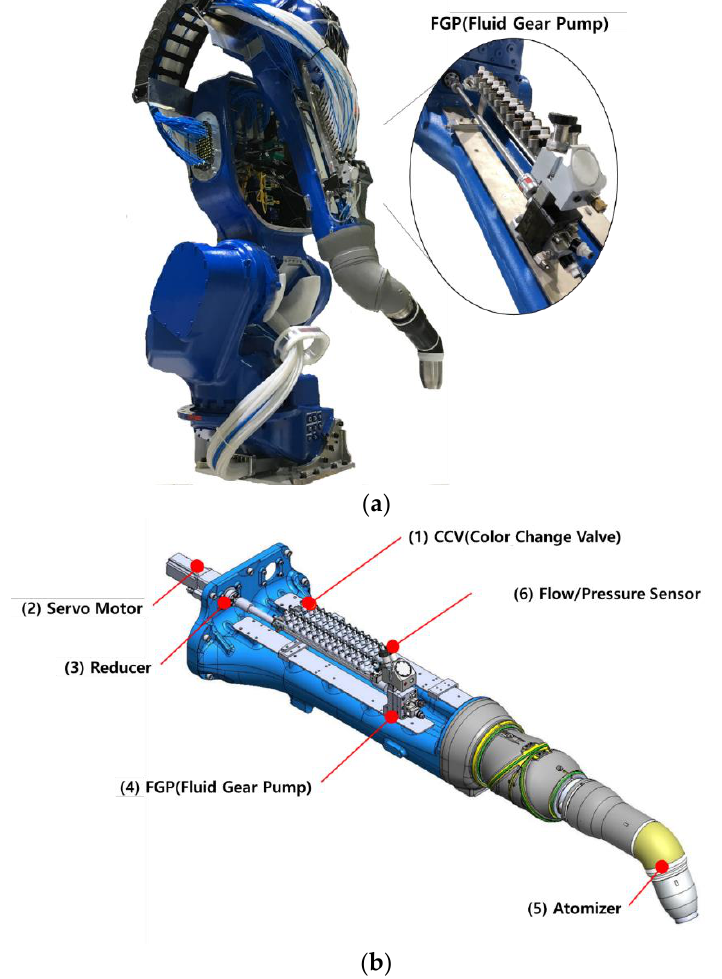
Figure 2. Configuration of the painting system; ( a ) the robotic arm of the automated automotive painting system; ( b ) the details of the painting system using the fluid gear pump.